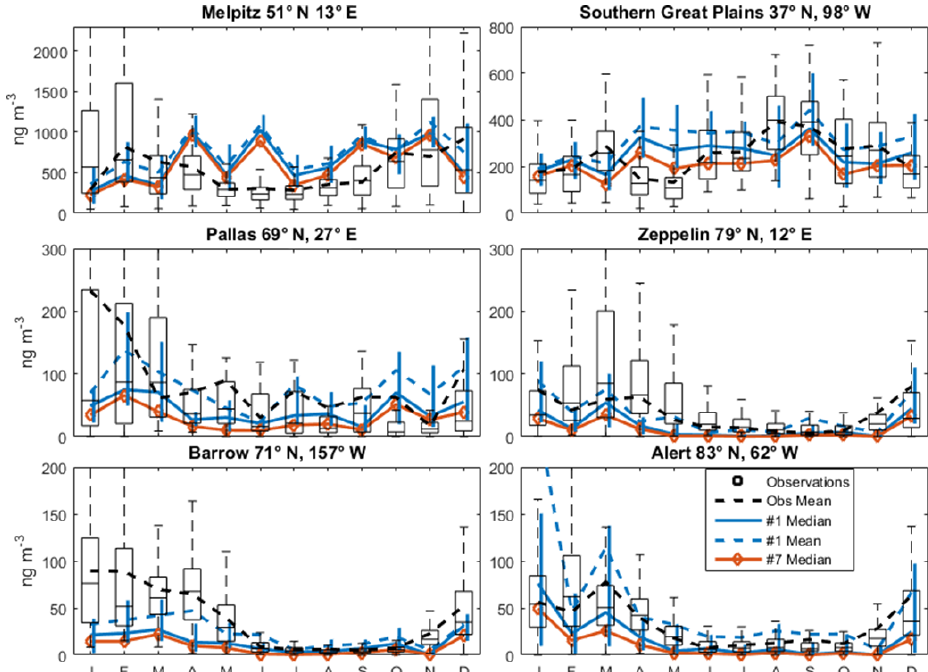
Figure 8. Modeled and observed monthly BC concentrations at six different measurement stations for the reference BC simulation. The black boxes cover the 25–75% percentile range, the black horizontal line the median, and the black whiskers the 10–90% percentile range of the observations. Modeled median values are plotted in blue with vertical lines showing the 25–75% percentile range. The stippled blue line shows the model mean. Also shown are the median values obtained from simulation